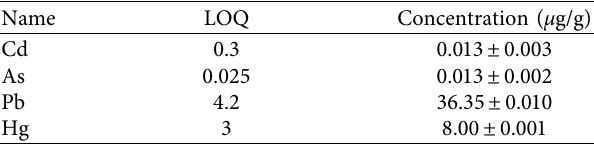
Table 3: Heavy metals of tunichrome released from Phallusia nigra Persian Gulf marine tunicate.